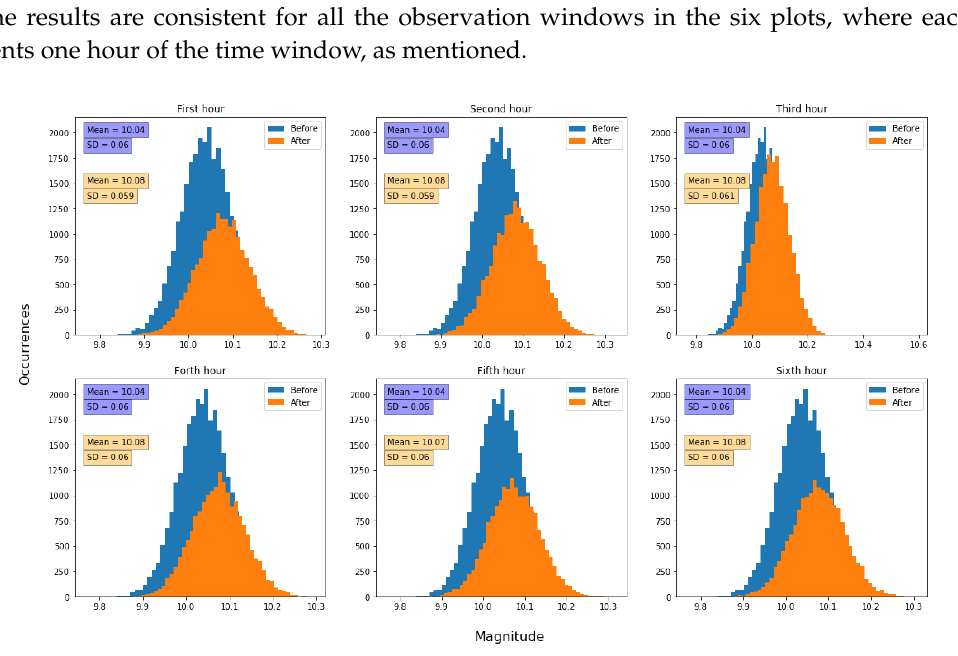
Figure 17. Histogram representation for the outside sensor, before and after inserting the RPWs for the first six